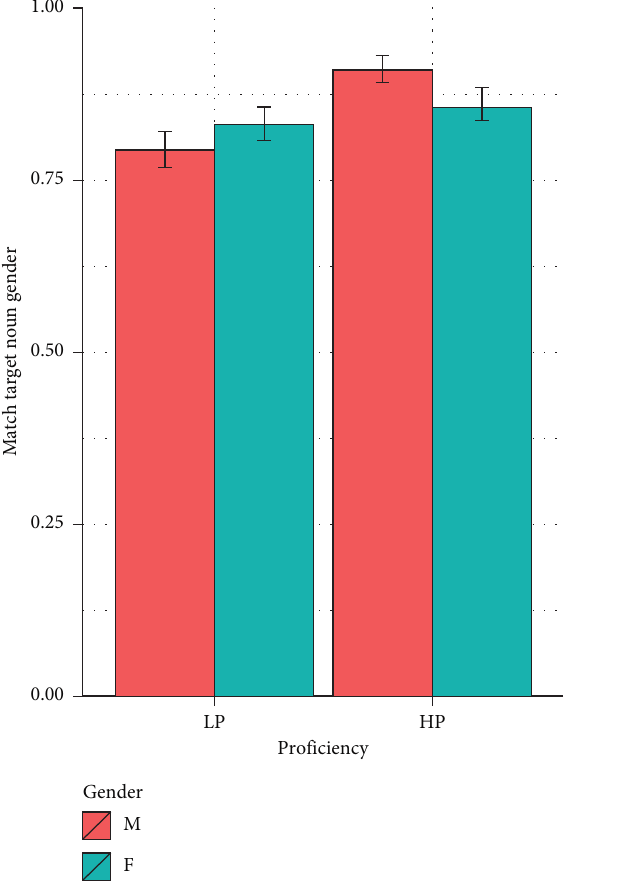
Figure 6: Correct mean % of the comprehension task by profi- ciency and gender.